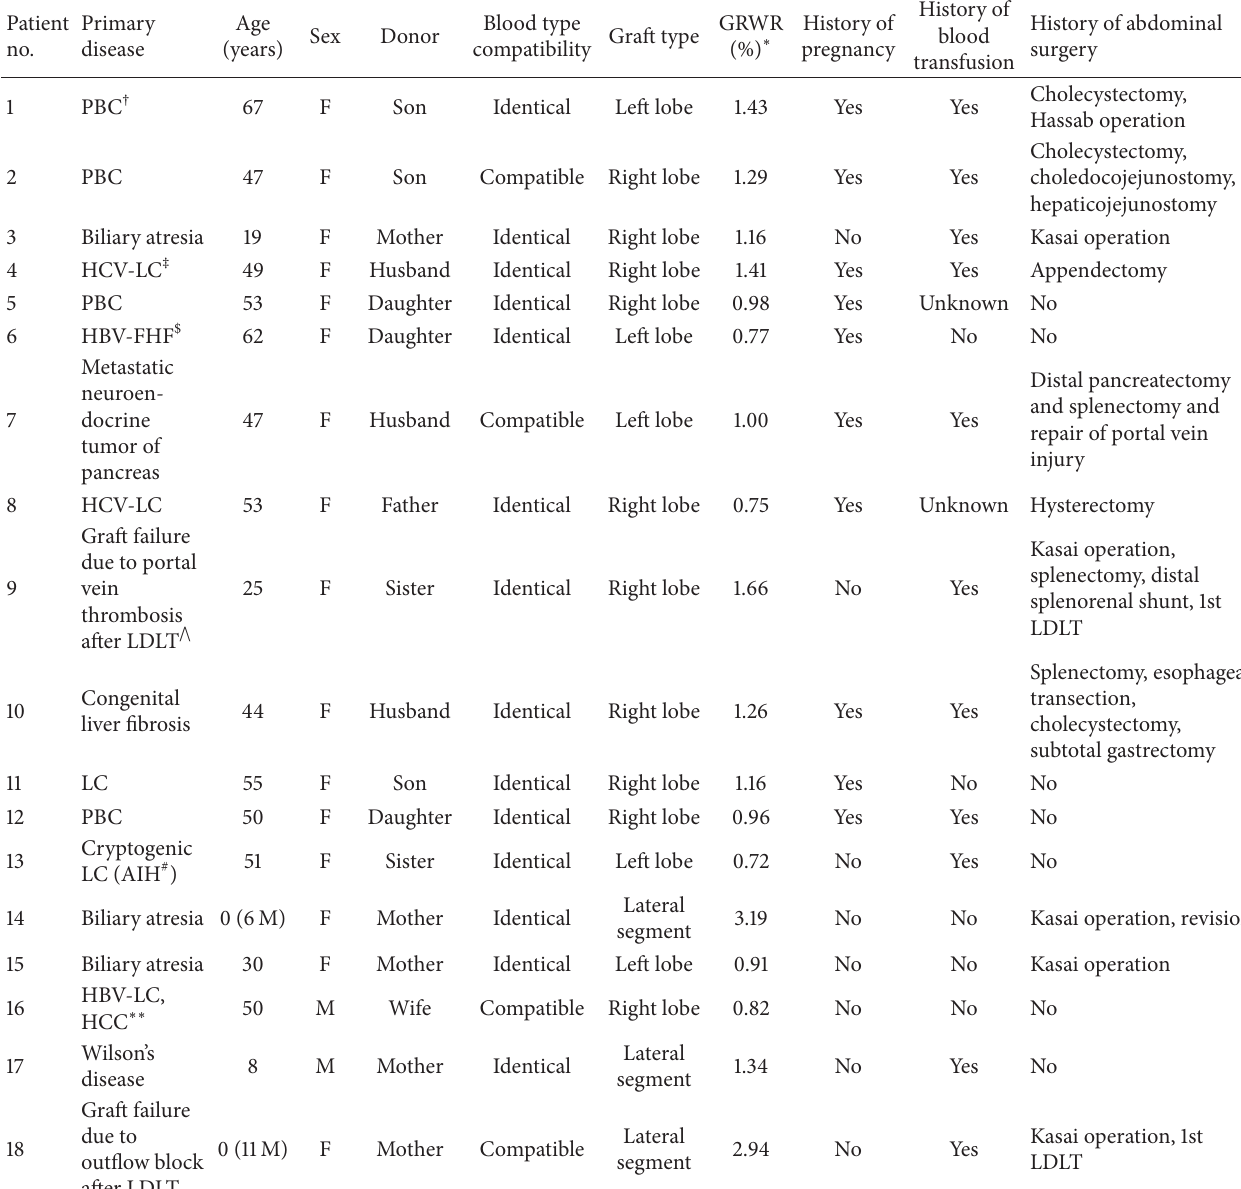
Table 1: Profiles of crossmatch-positive